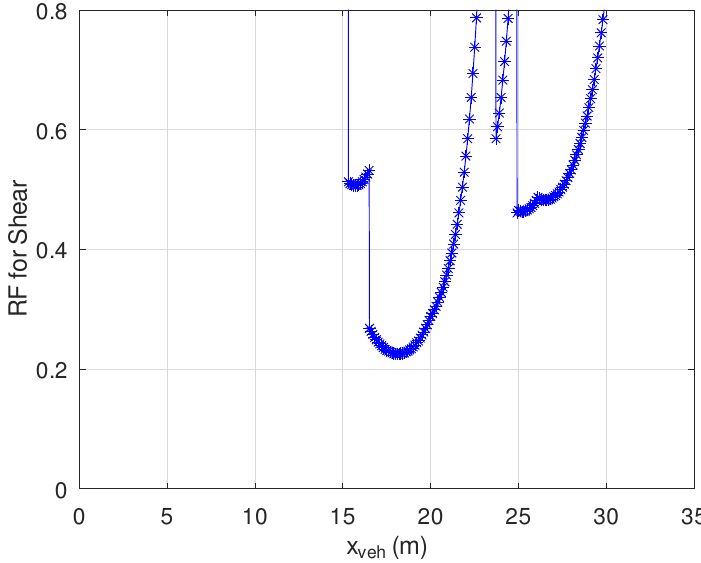
Figure 11. Rating Factor for shear versus x veh for the two-span